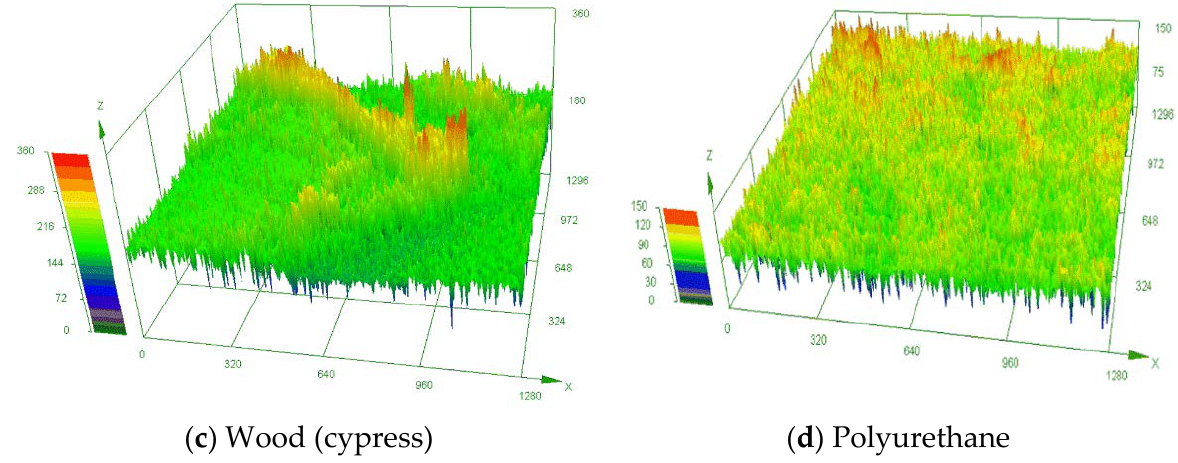
Figure 5. Cloud maps of wear tests for different materials( a ) cloud map of surface wear for rubber, ( b ) cloud map of surface wear for Nylon, ( c ) cloud map of surface wear for wood(cypress), and ( d ) cloud map of surface wear for Polyurethane.